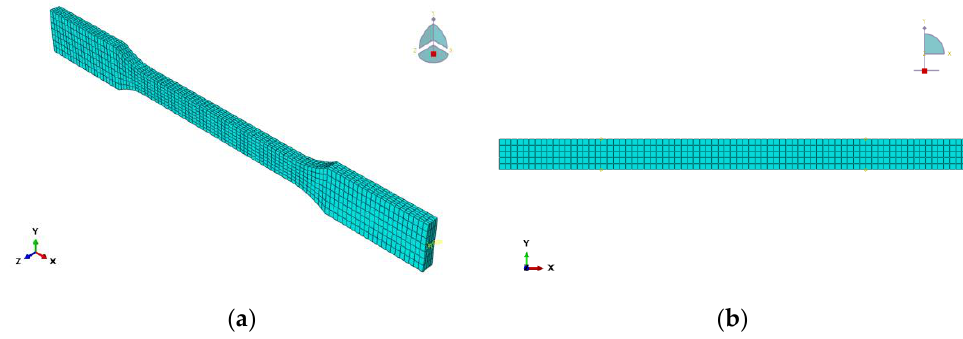
Figure 32. Mesh Dividing: ( a ) epoxy resin adhesive sheet and ( b ) CFRP sheet.